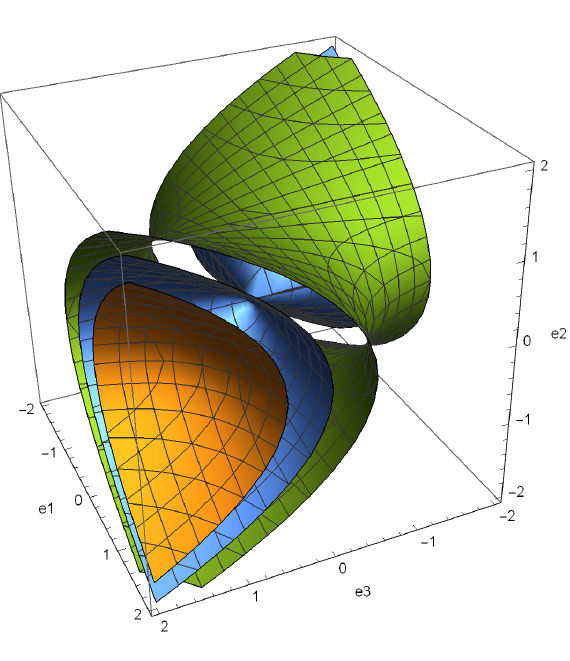
Figure 1. Representative symplectic leaves of the KKS bracket on sl ∗